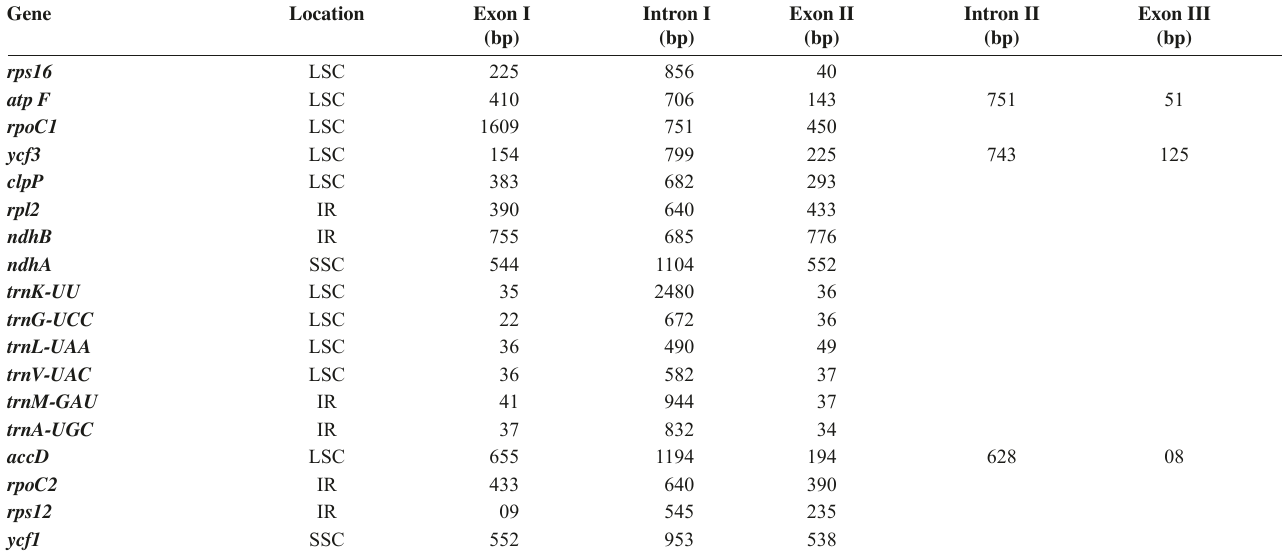
Tab. 3: Genes with introns in the sequence of Caralluma quadrangula cp